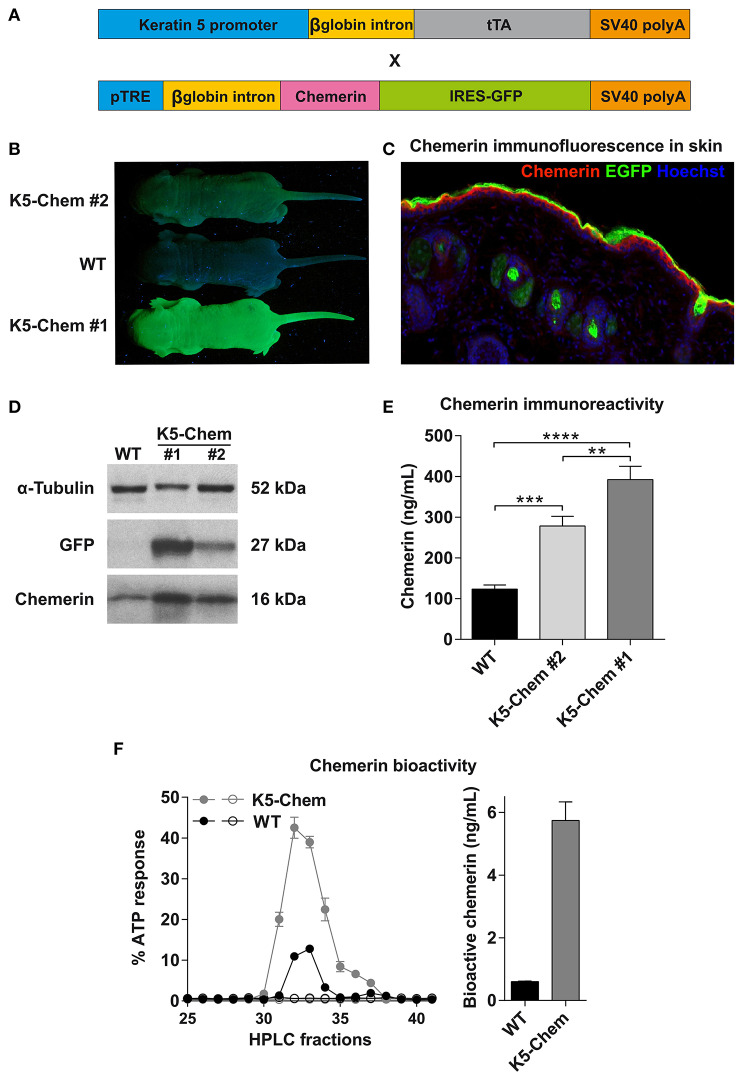
Development of a mouse line expressing bioactive chemerin in keratinocytes. (A) Schematic representation of the constructs used to generate the K5-chemerin transgenic mice overexpressing bioactive chemerin and EGFP in keratinocytes. (B) Detection of EGFP fluorescence in the skin of newborn mice from two K5-chemerin lines and a control mouse (WT). (C) Detection by immunofluorescence of chemerin in a skin section of a K5-chemerin mouse (line #1). (D) Detection by Western blotting of chemerin (16 kDa), EGFP (27 kDa) and α-tubulin (52 kDa, as control) in the skin from K5-chemerin (lines #1 and #2) and WT mice. Data are representative of four experiments. (E) Measurement by ELISA of chemerin immunoreactivity in plasma from control and K5-chemerin mice from two lines (mean ± SEM, n ≥ 5 mice per group). The data are representative of three experiments and analyzed by one-way ANOVA. **P < 0.01; ***P < 0.001, and ****P < 0.0001. (F) Measurement of chemerin bioactivity in the plasma of control and K5-chemerin mice (line #1). Pooled plasma was loaded on a heparin column and fractions tested in an aequorin-based intracellular Ca2+ mobilization assay, using CHO-K1 cells expressing mouse ChemR23 (closed symbols) or not (open symbols). The activity is expressed as the percentage of the response obtained for 10 μM ATP (left panel, representative experiment out of two). Bar graph representing the total bioactive chemerin level in plasma from control and K5-chemerin mice (right panel). For each condition, two pools of plasma were analyzed (mean ± SEM).